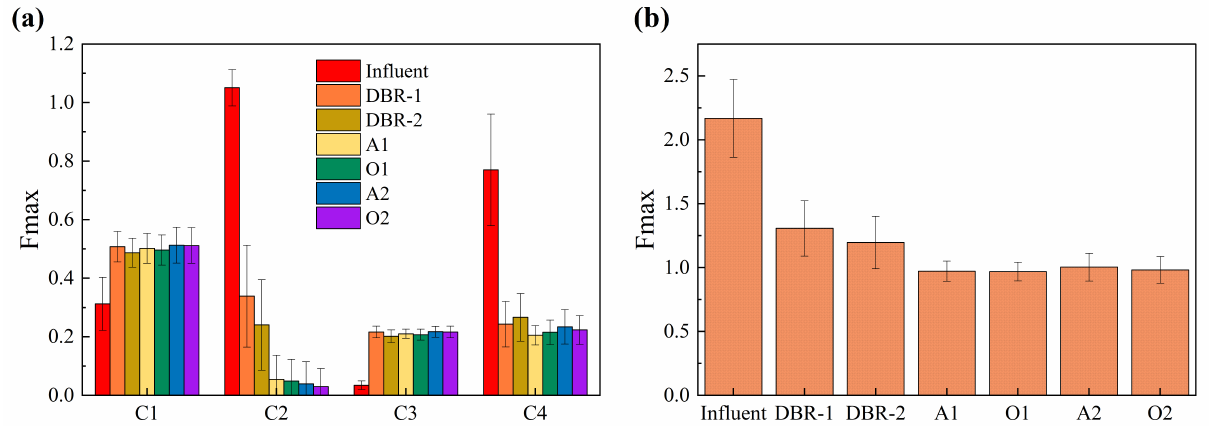
Figure 4. Average maximum fluorescence intensity (Fmax) of ( a ) each organic component and ( b ) all four organic components in different reactors of 25